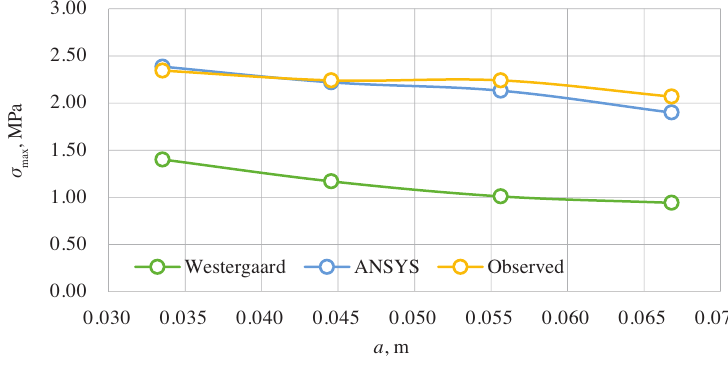
Figure 10. Variation of load area radius ( h = 2.54 cm and load at the edge)